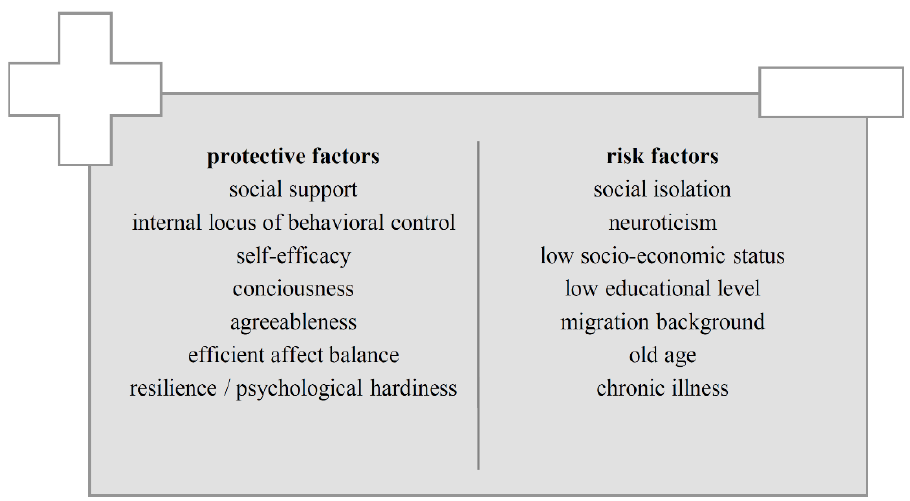
Figure 1. Important protective and risk factors relevant to health behavior beyond the Health Be- lief Model